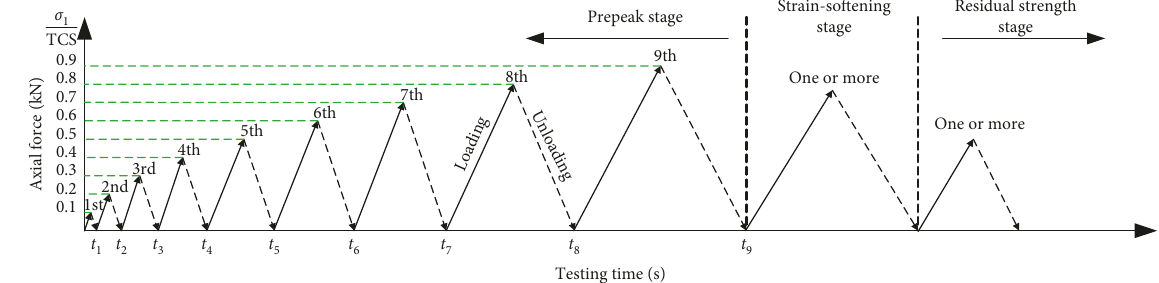
Figure 3: Experimental loading-unloading path.